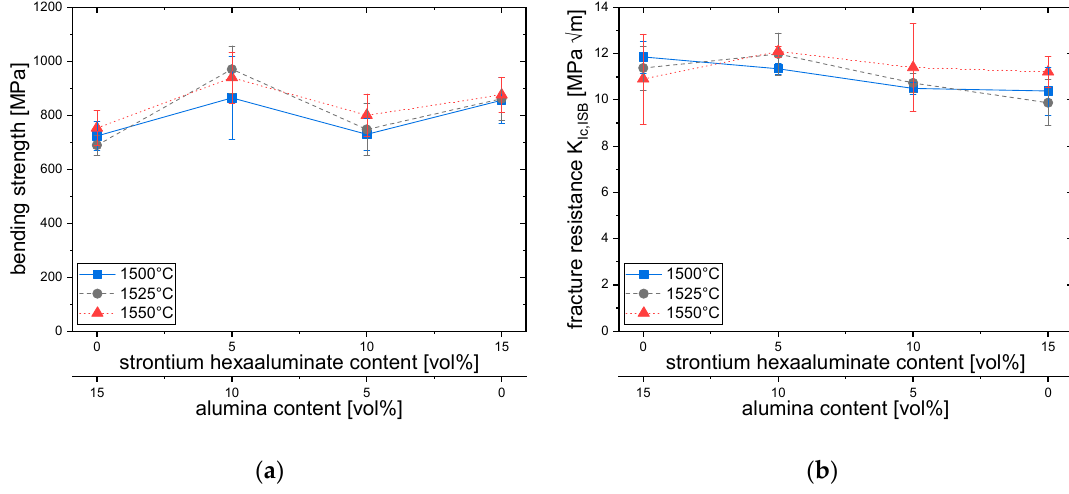
Figure 4. Mechanical properties depending on composition and sintering temperature for: ( a ) Bending strength σ 4pt ; ( b ) Fracture resistance K ISB .